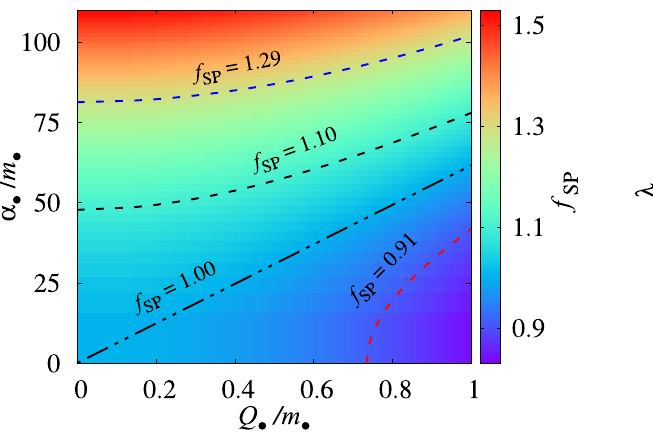
Fig. 3 The color-indexed f SP for the black-bounce-Reissner– Nordström spacetime against the charge Q • and bounce parameter α • is shown. The black, red and blue dashed lines represent the best-fit estimation of, the lower and the upper limit of S2 star’s f SP , respec- tively, while the dash-dotted line marks the line of f SP = 1 for the Schwarzschild precession